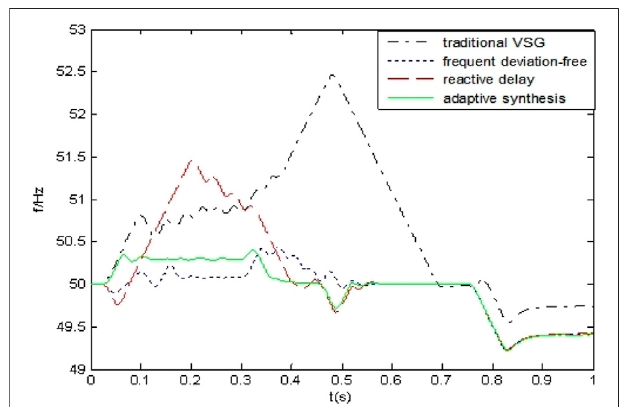
FIGURE 7 | Active output of the microgrid.